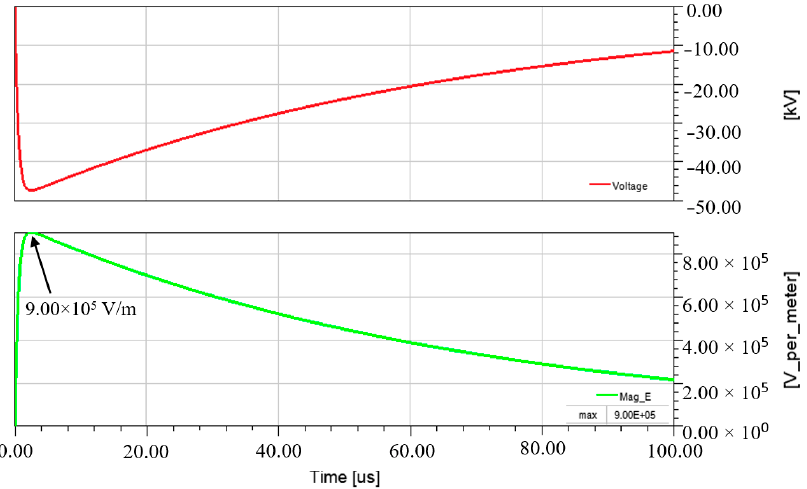
Figure 11. Voltage and E-field strength on GFRP surface (at position A).